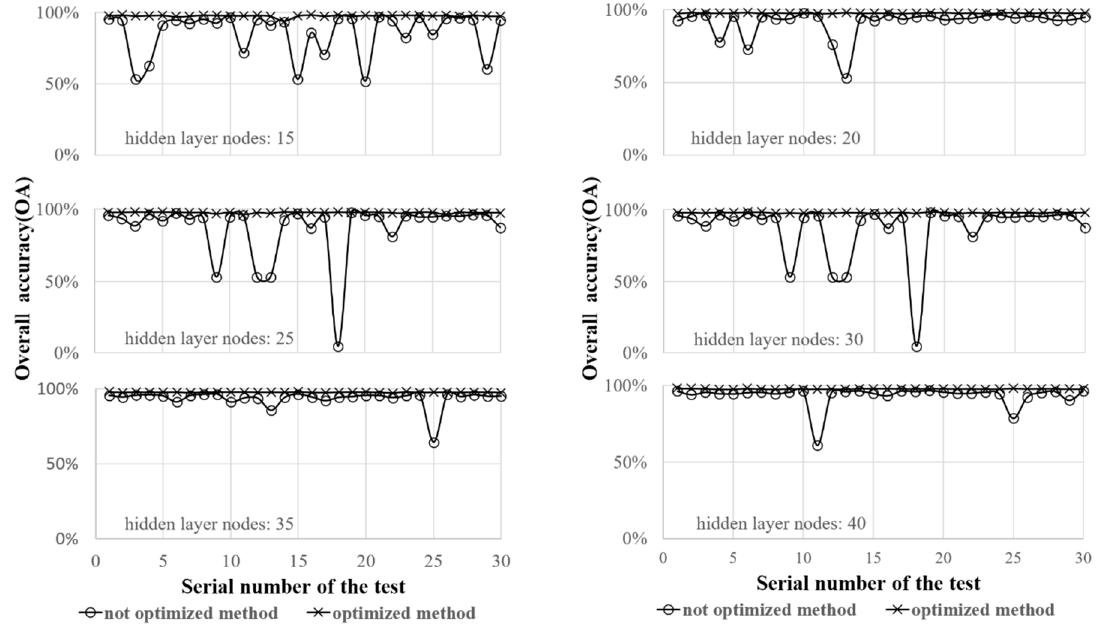
Figure 10. Classification overall accuracy of optimized and un-optimized WNN with different hidden layer nodes of Dataset 1.